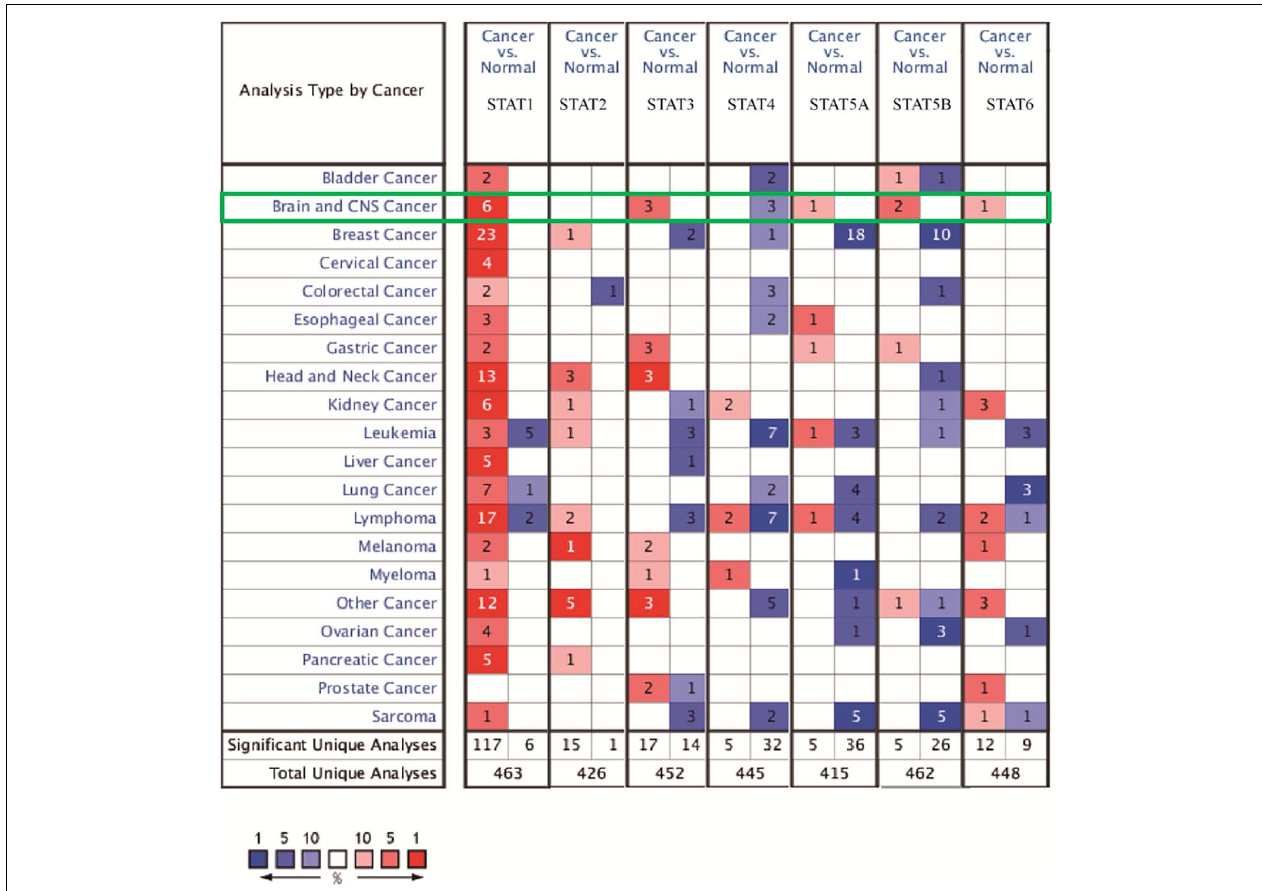
FIGURE 1 | mRNA expression of the STAT gene family in different types of cancers (analyzed with Oncomine database). Search parameters were: fold change = 2, P -value = 0.01. The value in the tables represents the number of datasets that conform to the thresholds. The color intensity (red or blue) is positively related to the degree of upregulation or downregulation, respectively. The mRNA expression of the STAT gene family in glioma is sketched with green highlights.